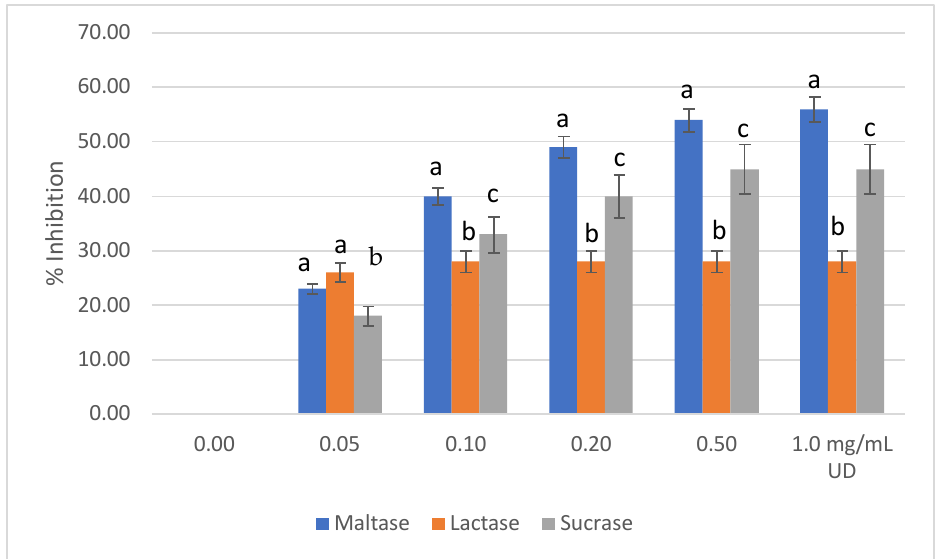
Figure 2. Means of inhibition % (±SD) of maltase, lactase, and sucrase activities by different concen- trations of UD extract, as measured by the concentration of released glucose. Values with different letters are significantly different ( p ≤ 0.05).